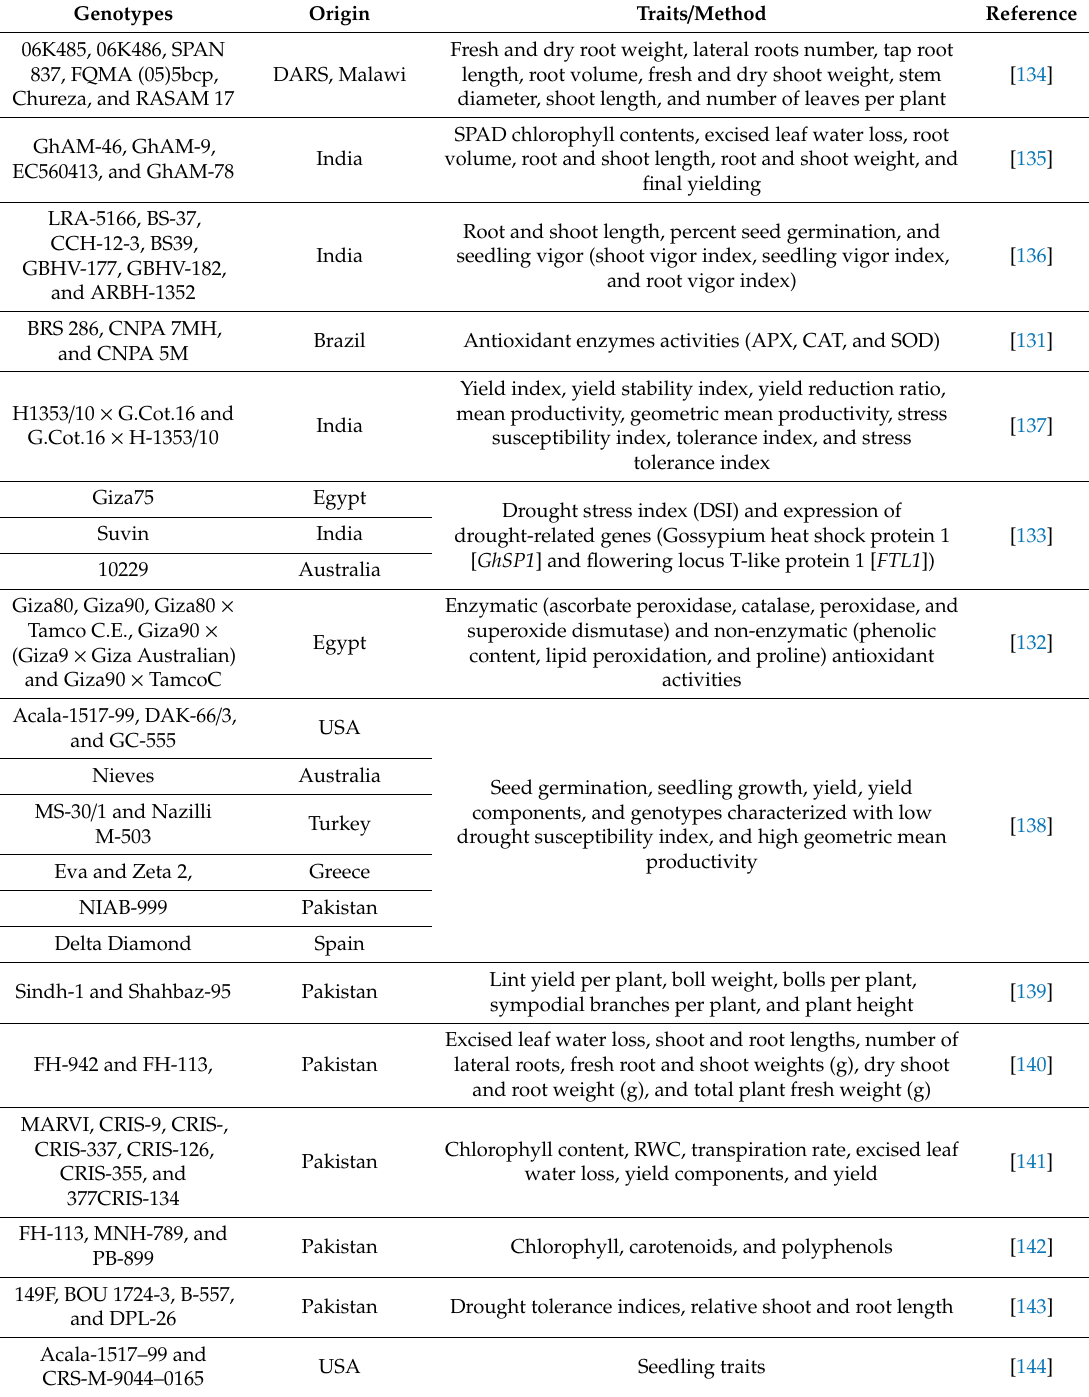
Table 3. Reported drought-tolerant cotton genotypes and the genetic basis for drought